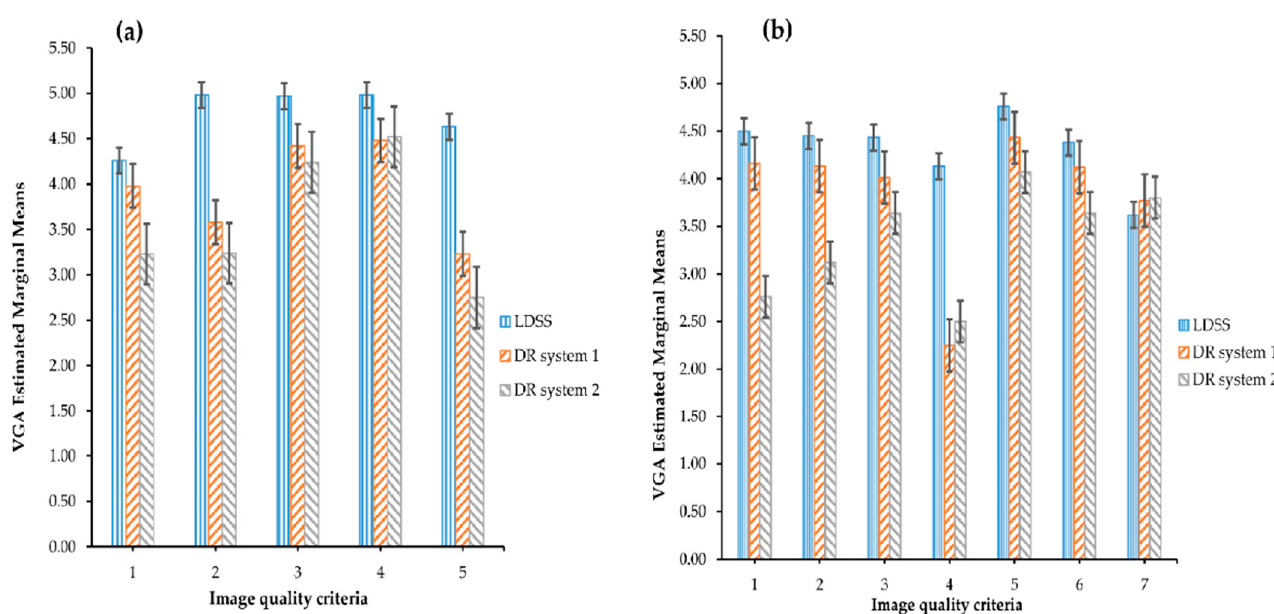
Figure 2. VGA estimated marginal mean comparison across the imaging systems and image quality criteria for ( a ) the chest PA projection and ( b ) the chest LAT projection .